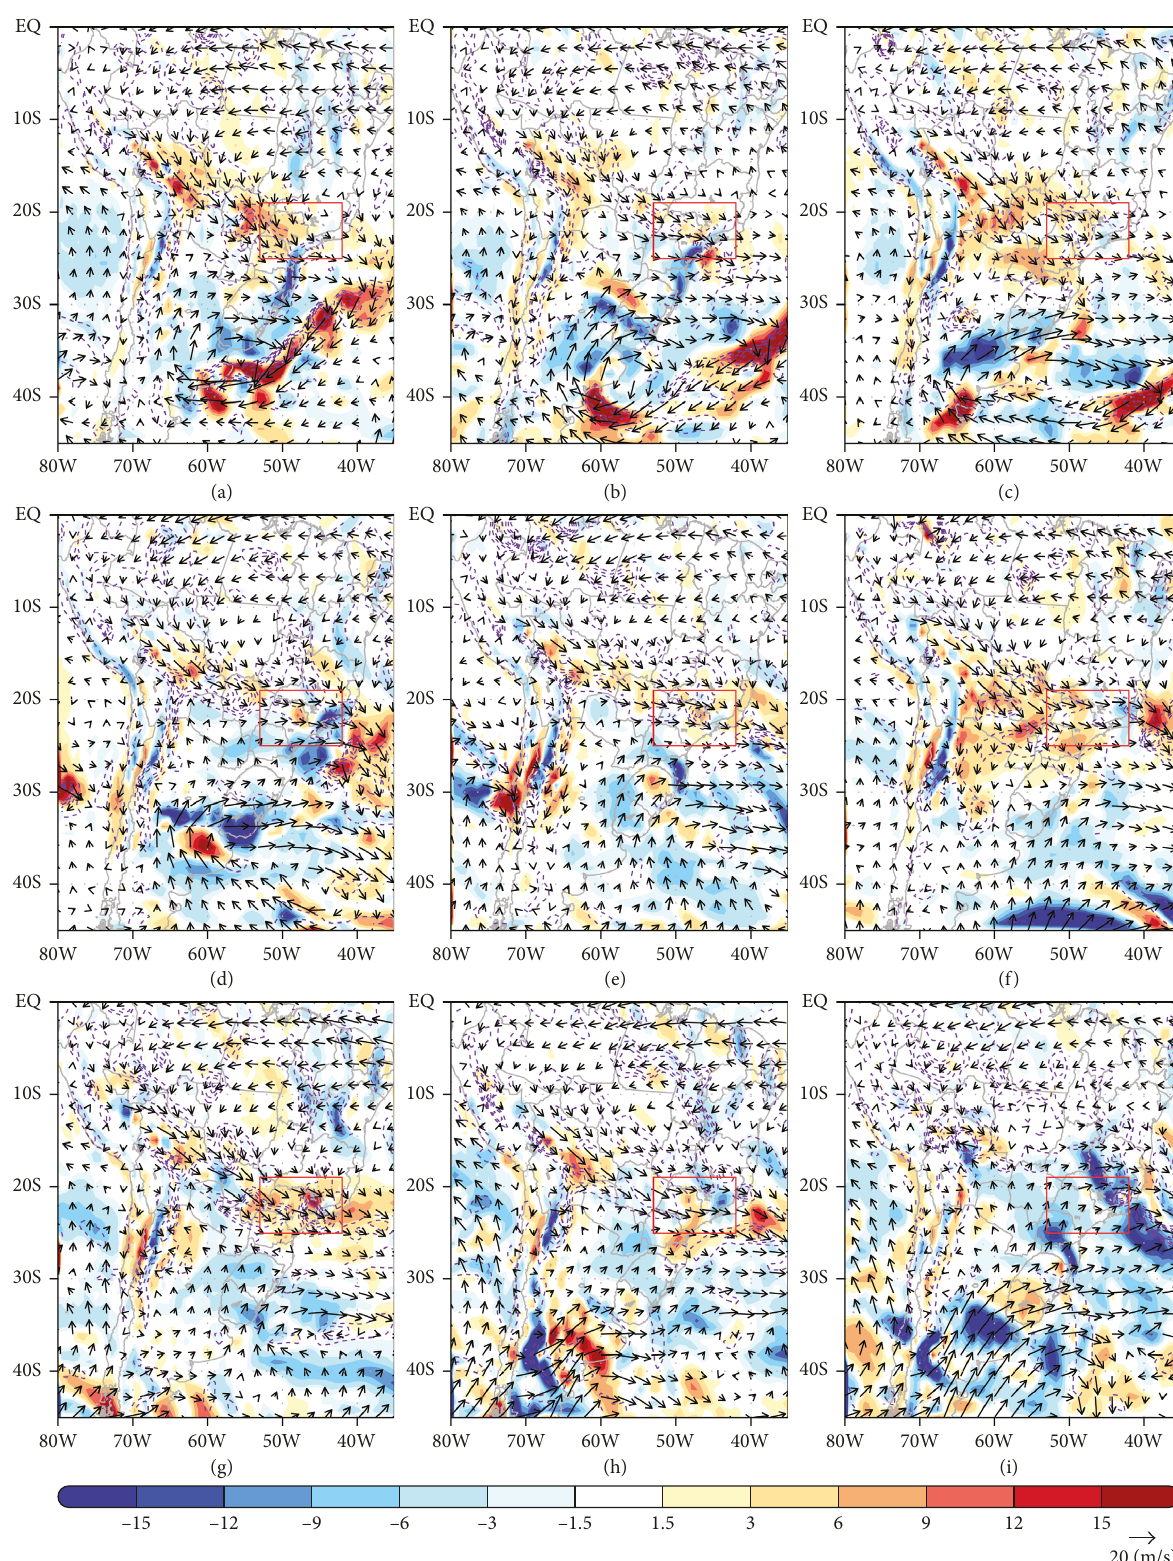
Figure 4: Horizontal temperature advection (shaded; K